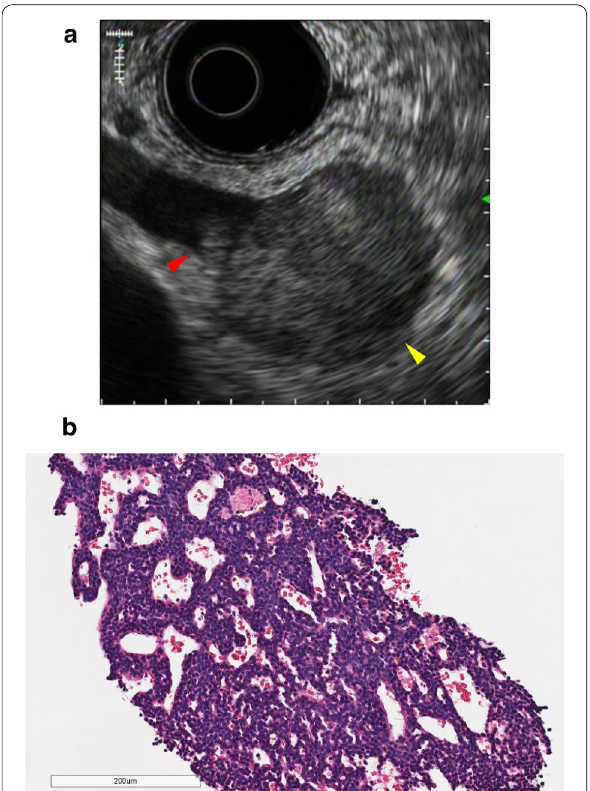
well-circumscribed round tumor (yellow arrowhead). An intravenous high echoic mass invading the SMV is shown adjacent to the main tumor (red arrowhead). b Hematoxylin–eosin (HE) staining of the EUS-FNA-obtained specimen exhibiting small, round-to-oval tumor cells with round nuclei and scant